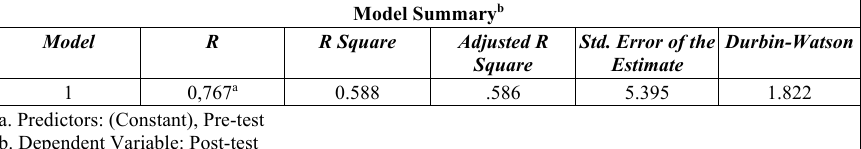
Table 4. Regression test result of pre- and post-test